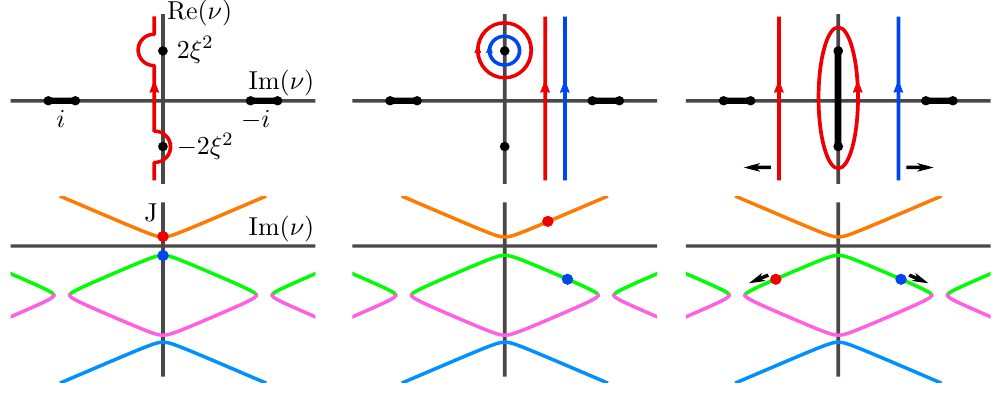
Figure 10 . The movement of contours along the J trajectories. The upper panels indicate the J L and J R contours in the ν -plane while the lower panels indicate their corresponding position on the J solution sheets. The strategy to expand in the Regge limit is to move down as fast as possible (so as to J ), as shown in the third